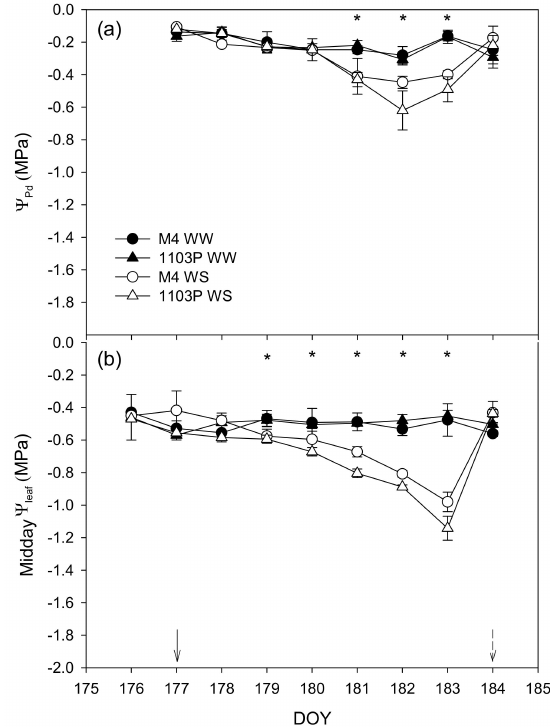
Figure 1. Trends for pre-dawn water potential ( Ψ pd , panel a ) and midday leaf water potential ( Ψ leaf , panel b ) of vines cv. Grechetto Gentile grafted to M4 and 1103 Paulsen. M4-WW = well-watered vines grafted to M4; 1103P-WW = well-watered vines grafted to 1103 Paulsen; M4-WS = water-stressed vines grafted to M4; 1103P-WS = water-stressed vines grafted to 1103 Paulsen; DOY = day of the year. Bars represent standard errors ( n = 3). Asterisk indicates dates within which significant di ff erences among treatments were found, according to the Student–Newman–Keuls (SNK) test ( p < 0.05). Solid arrow indicates date of imposition of WS; dashed arrow indicates date of